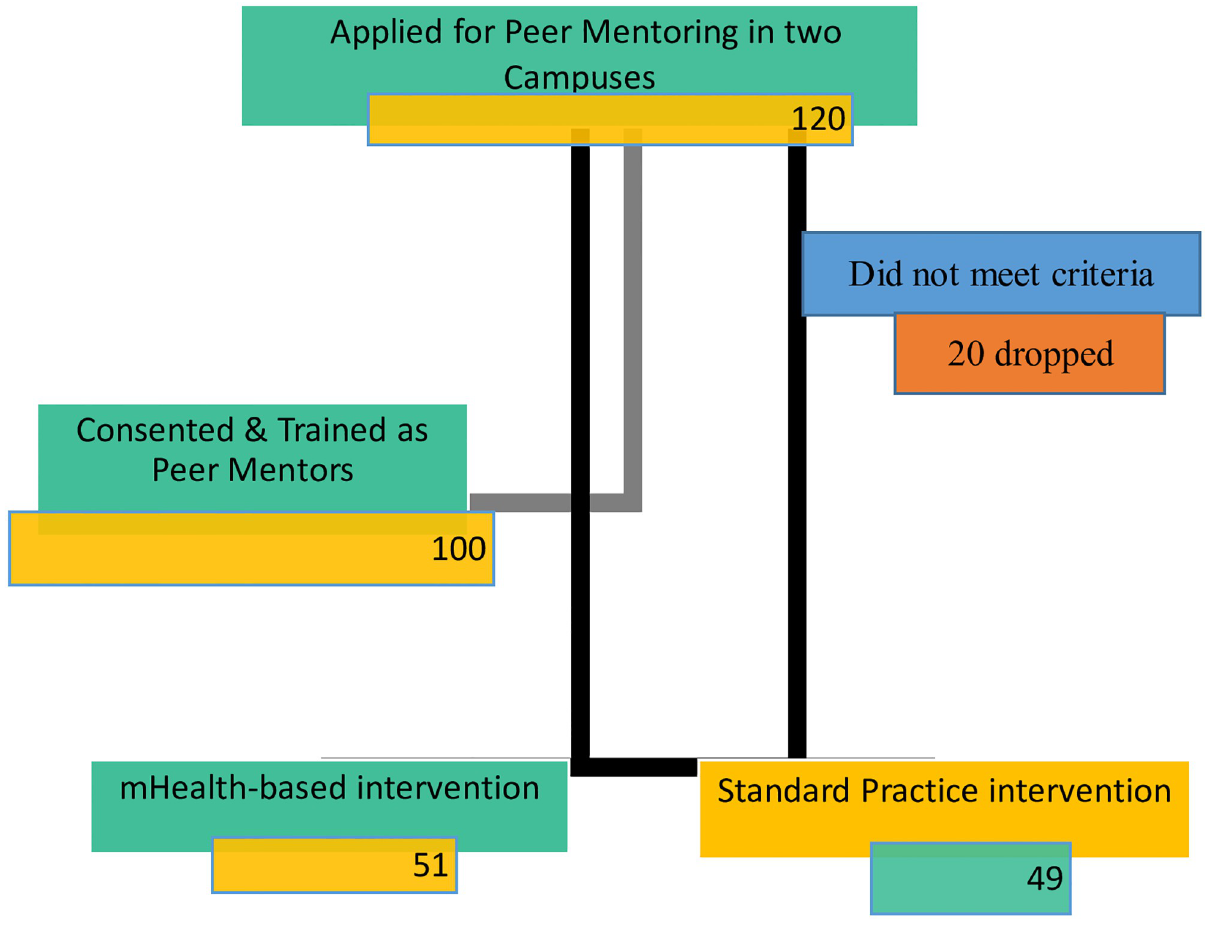
Fig 4. Flowchart of interview and consenting